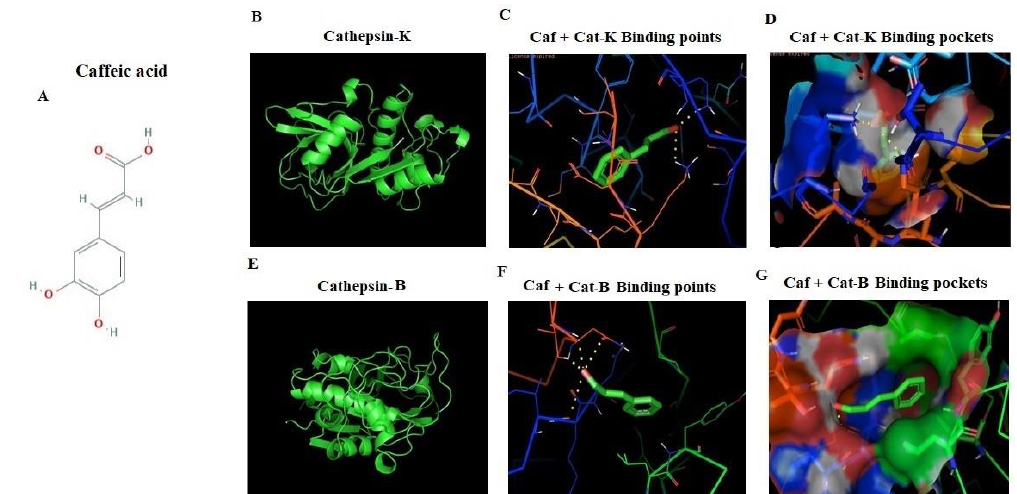
Figure 6. In silico interaction of caffeic acid (CAF) with cathepsin family receptor molecules. Docked orientation of ( A ) CAF (CID_637511), ( B – D ) 3D structure of cathepsin-K (PDB ID: 6QLM), hydrogen bonds between CAF with cathepsin-K, binding pocket of cathepsin-K. ( E – G ) 3D structure of Cathepsin-B (PDB ID:3AI8), hydrogen bonds between CAF with cathepsin-B, binding pocket of cathepsin B with CAF complex. Docking analysis was performed using Autodock tools (ADT) and Autodock v4.2 software. Table 2. Hydrophobic interaction of caffeic acid and amino acid residues of target proteins. SL.